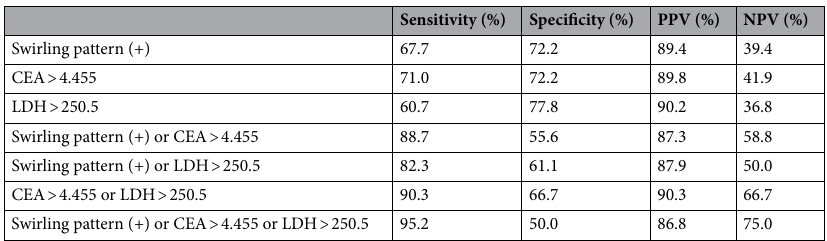
Table 3. Comparing different methods for predicting patient diagnosis status. PPV positive predictive value, NPV negative predictive